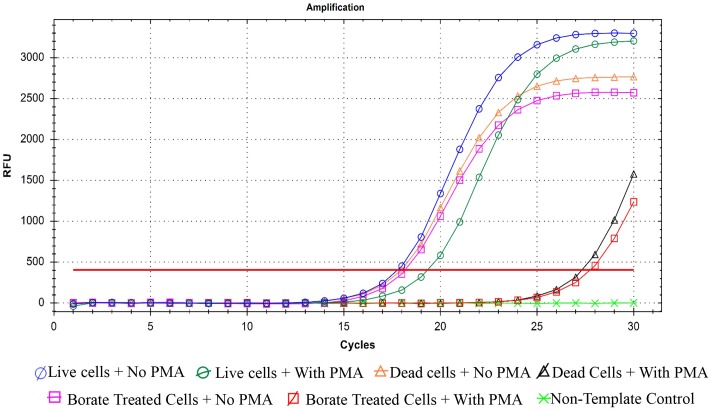
Quantification real-time PCR for P. carotovorum treated with 100 mM potassium tetraborate tetrahydrate (PTB) with and without propidium monoazide (PMA). Data are averages of three separate experiments.